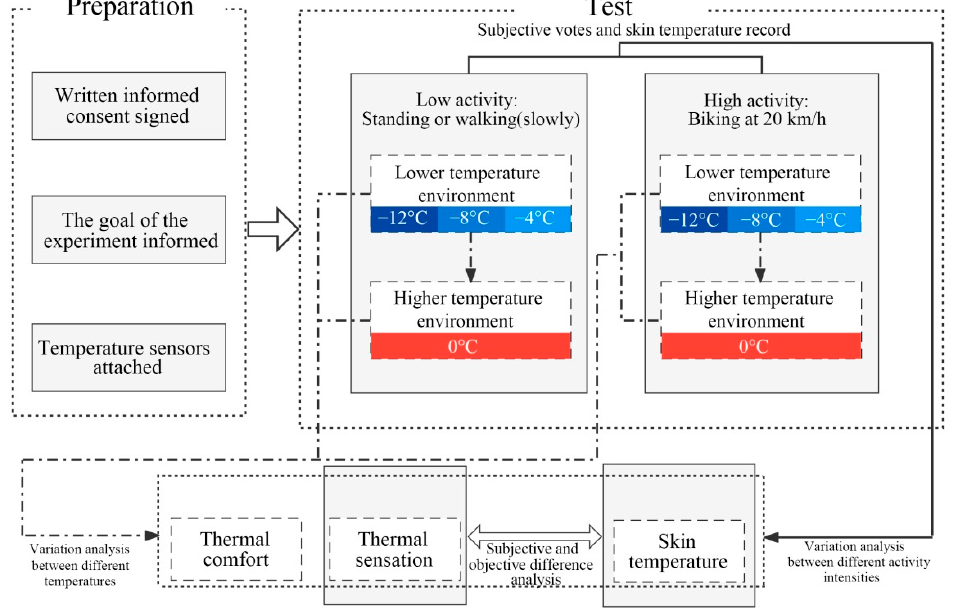
Figure 5. The conceptual framework of the experimental study.